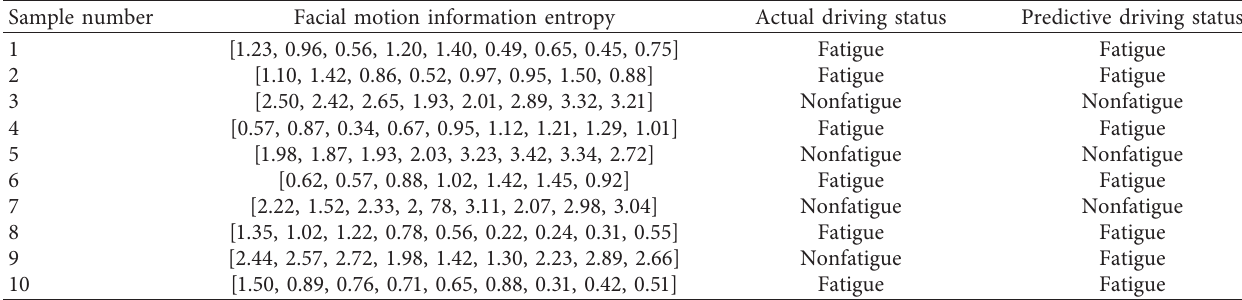
Table 2: Sample fatigue test table.